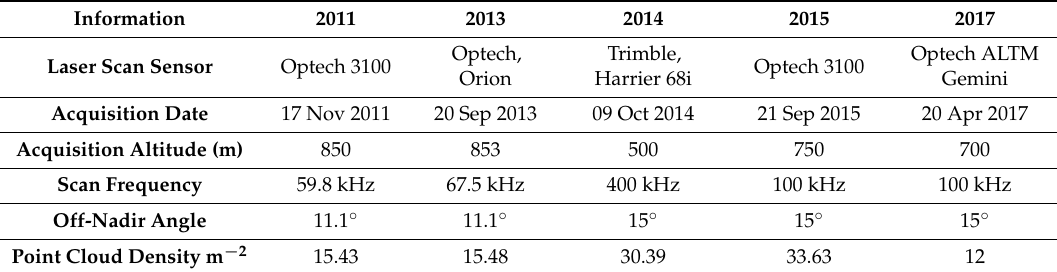
Table 2. Acquisition details of Airborne LiDAR data used for gap recovery